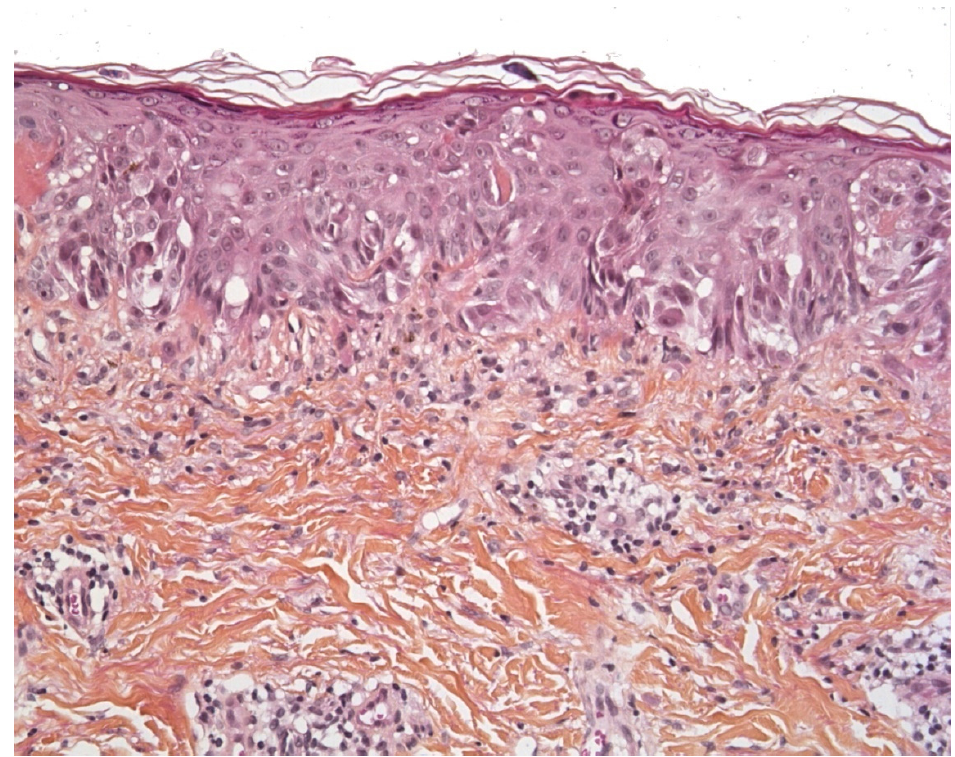
Figure 8. Pagetoid Spitz nevus (HE ×250). Epithelioid or spindle melanocytes with large nuclei and abundant “ground glass” cytoplasm, and pagetoid spread.